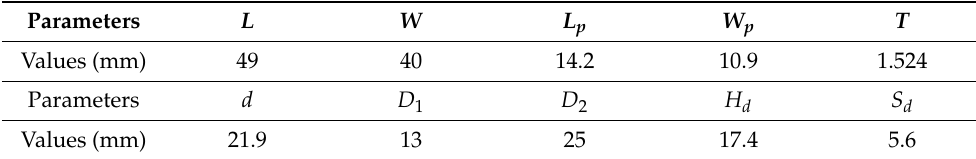
Figure 22. Simulated radiation pattern of the anchor antenna. ( a ) 6.3 GHz. ( b ) 6.4 GHz. ( c ) 6.5 GHz. ( d ) 6.6 GHz.